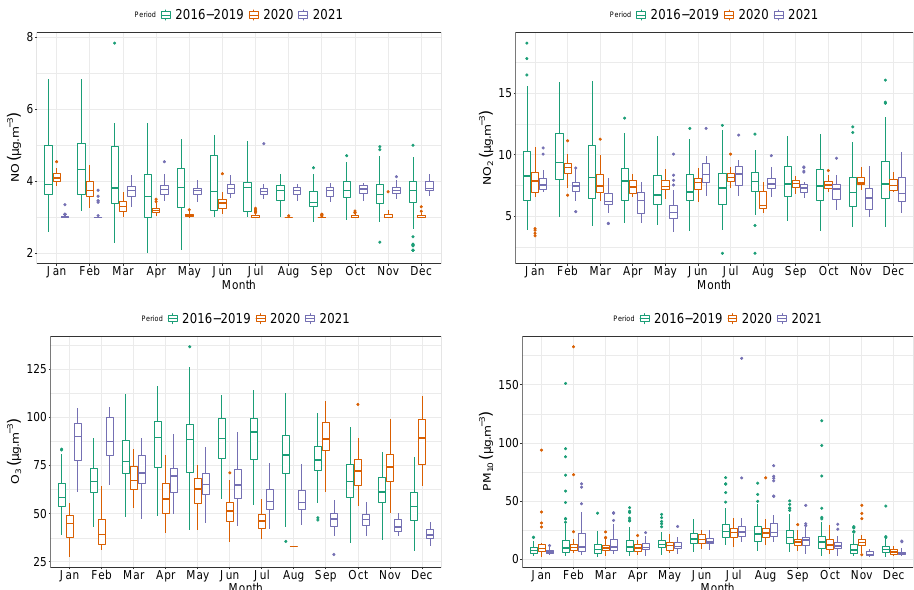
Figure 10. Box and whiskers plots of the daily concentrations of NO, NO 2 , O 3 , and PM 10 at the Caravaca station. The bottom and top of the box represent the first and the third quartiles, respectively; the horizontal line in the box represents the median; dots are the outliers; whiskers are the lowest and highest values, excluding the outliers. Table 1. Number of days per calendar year and number of days averaged over three years with a